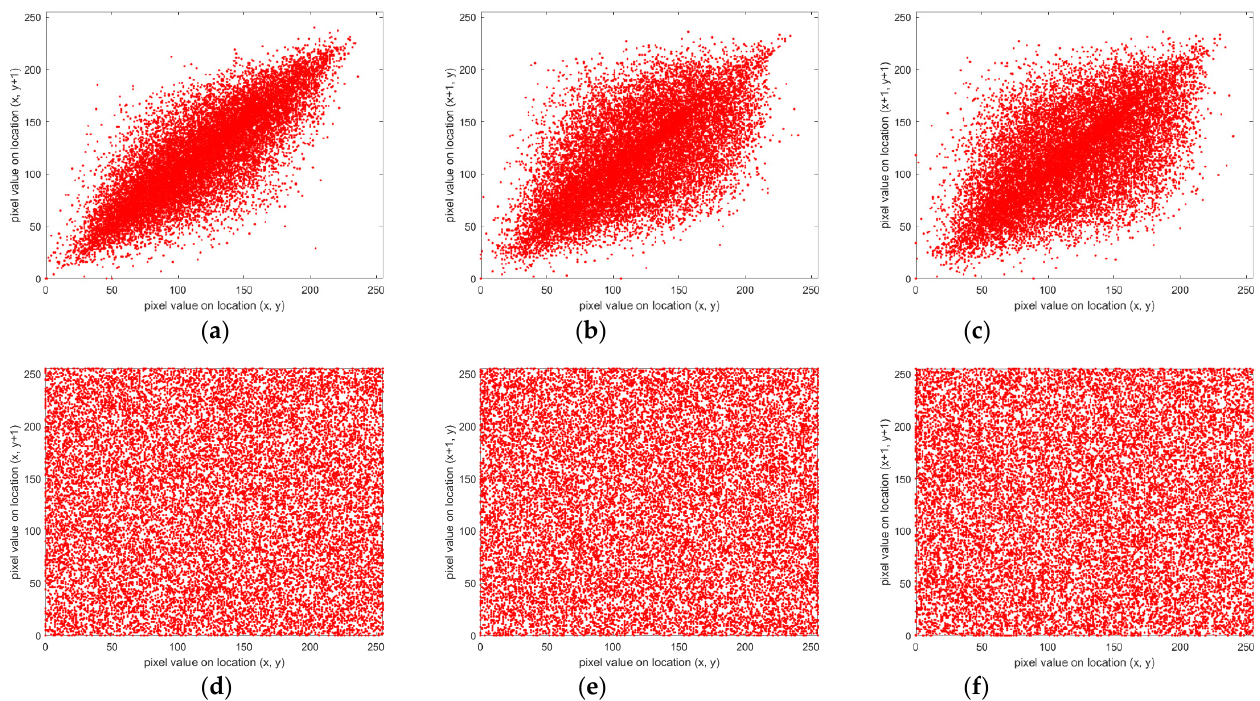
Figure 17. Red-component Adjacent pixel correlation of Baboon and corresponding cipher image: ( a ) Horizontal direction; ( b ) Vertical direction; ( c ) Diagonal direction; ( d ) Horizontal direction; ( e ) Vertical direction; ( f ) Diagonal direction.